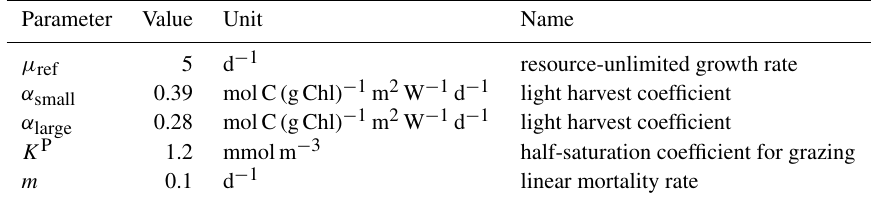
Table A4. Parameter values used in MARBL to compute the production and loss of small and large phytoplankton. Parameter Value